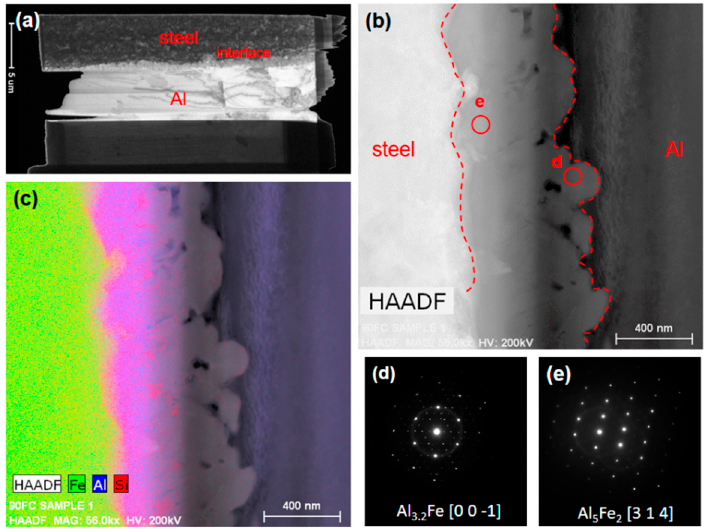
Figure 12. TEM micrographs of the interfacial microstructure at SZ of sample A: ( a ) whole view, ( b ) HAADF interfacial image, ( c ) EDS combination elemental map and SAD patterns of ( d ) Position d and ( e ) Position e in ( b ).